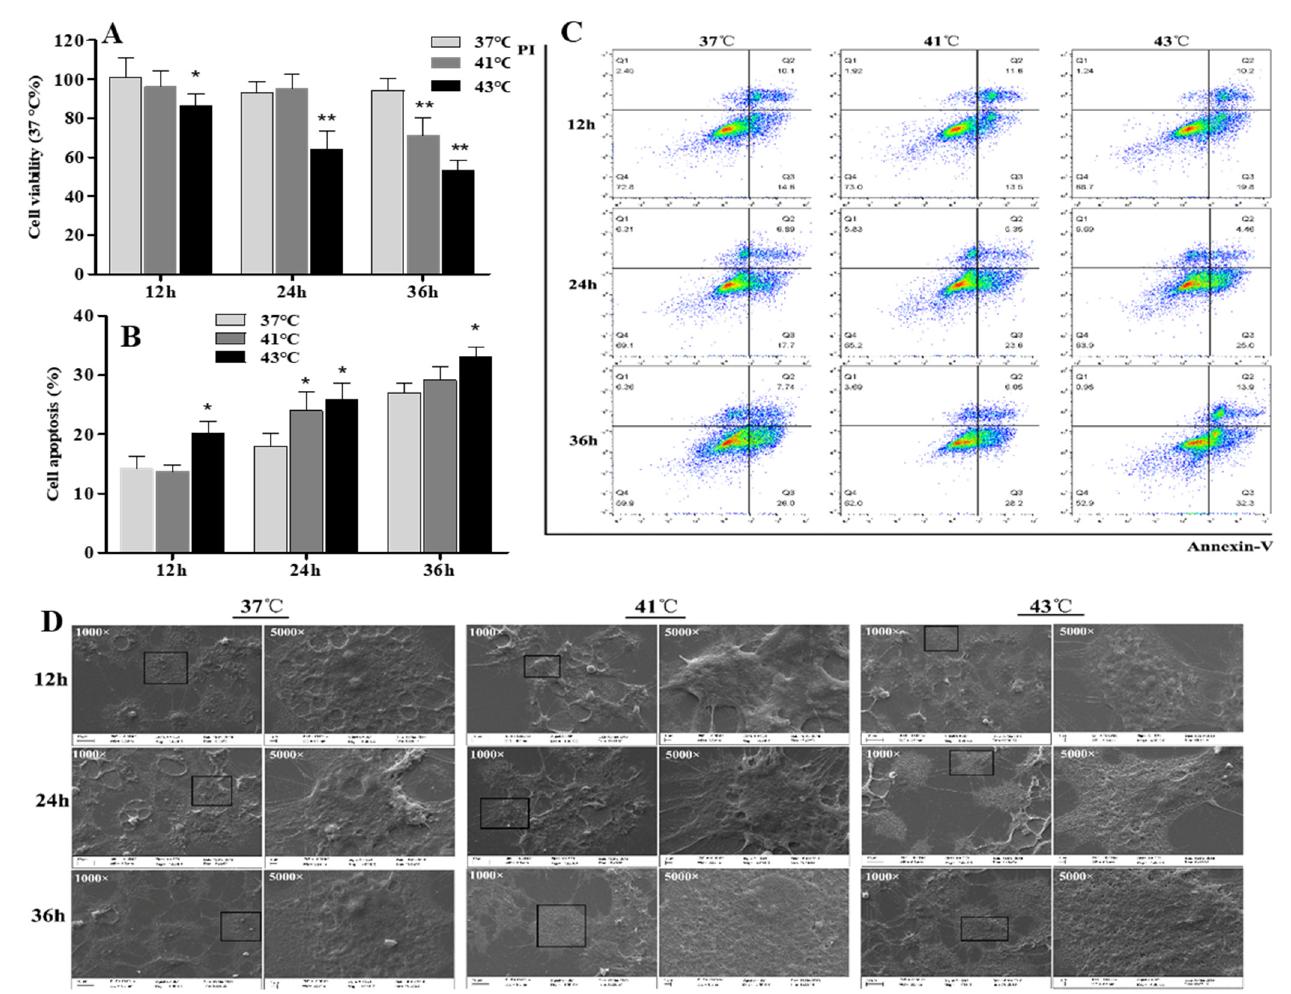
Figure 2. The effect of heat stress on cell vitality and apoptosis of granulosa cells. Primary cultured chicken GC were kept at 41 °C or 43 °C for 12 h, 24 h, or 36 h. ( A ) CCK-8 assay. ( B , C ) Flow cytometric analysis, with cells in the area of the lower right corner (Q3) indicating FITC Annexin V-positive cells. ( D ) Scanning electron microscope after heat treatment for 12 h, 24 h, and 36 h. The boxed areas at 1000× were magnified to 5000× and were observed. * p < 0.05, ** p < 0.01.